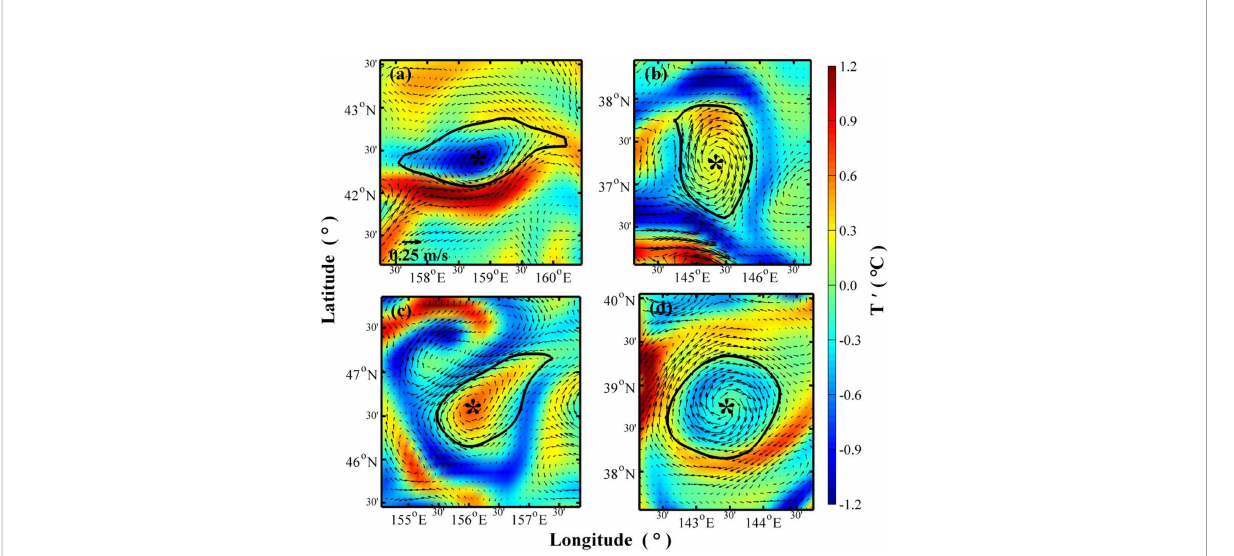
FIGURE 3 Individual cases of four types of mesoscale eddies. (A) Cyclonic cold-core eddy, (B) anticyclonic warm-core eddy, (C) cyclonic warm-core eddy and (D) anticyclonic cold-core eddy. Black vectors indicate geostrophic current anomalies, bold black curves (black asterisk) indicate the boundary (center) of the eddies, and the background color indicates temperature anomalies (units: